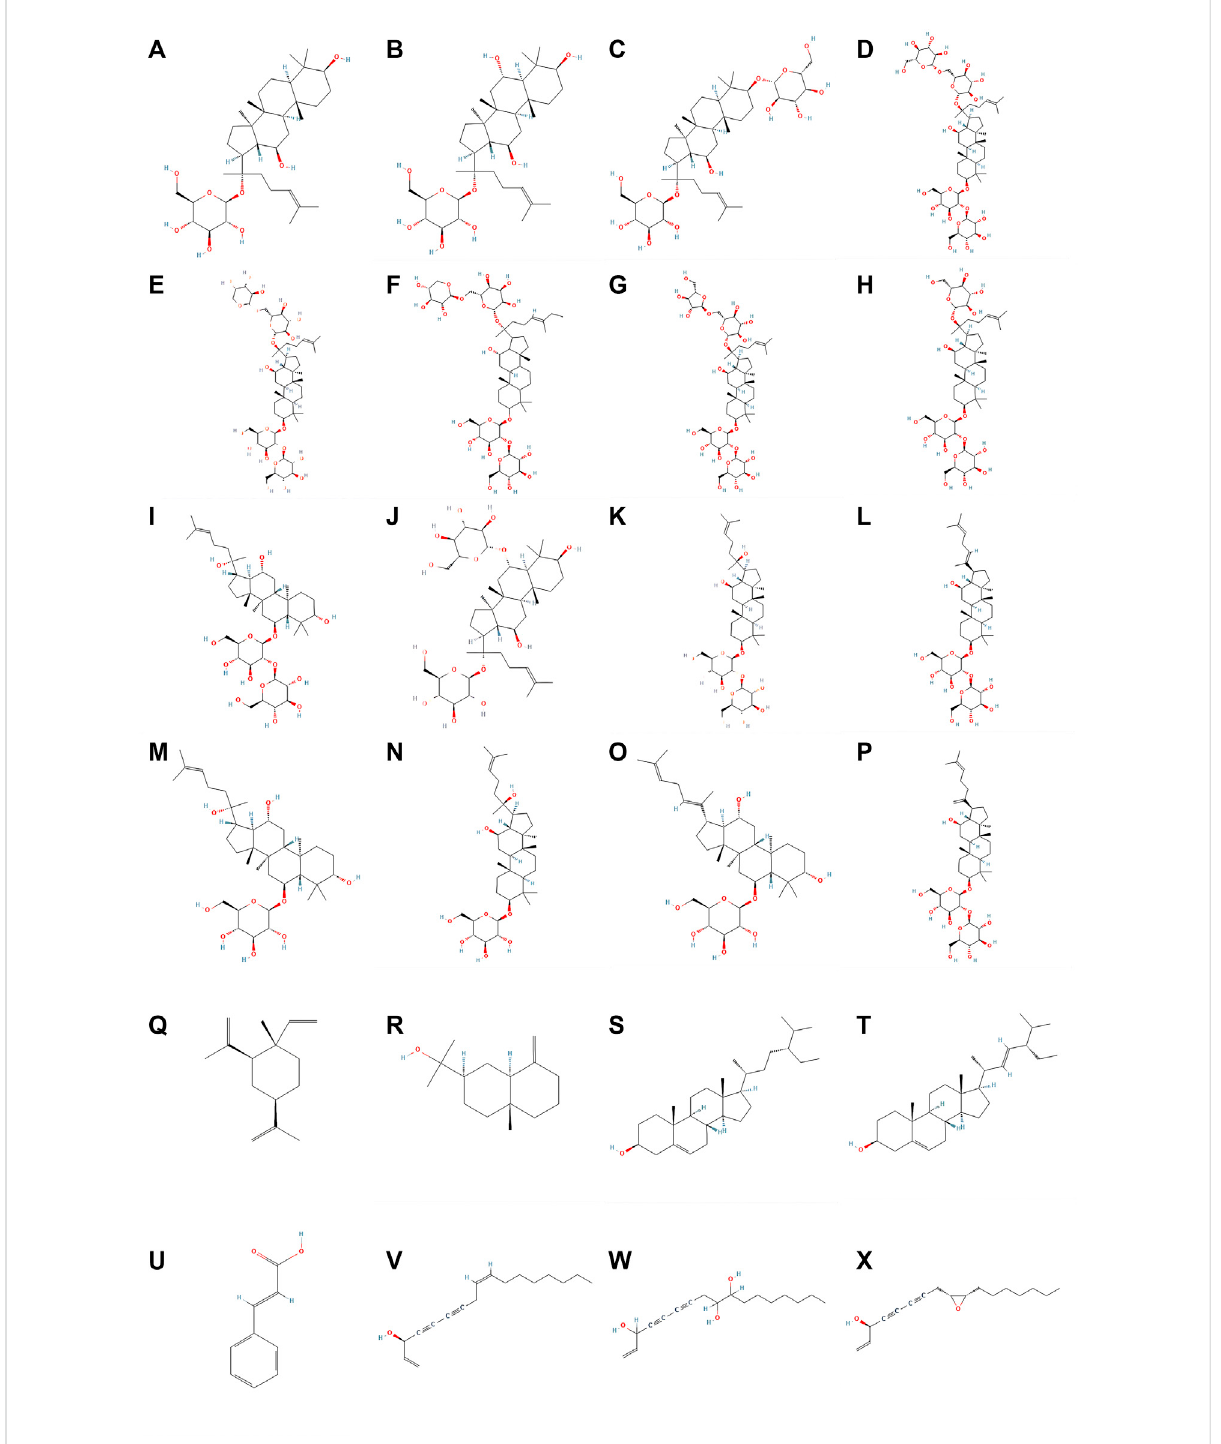
FIGURE 1 Molecular structureal formula of the main active ingredients of ginseng. (A) Ginsenosides-C-K (B) Ginsenosides-F1 (C) Ginsenosides-F2 (D) Ginsenosides-Rb1 (E) Ginsenosides-Rb2 (F) Ginsenosides-Rb3 (G) Ginsenosides-Rc (H) Ginsenosides-Rd (I) Ginsenosides-Rf (J) Ginsenosides-Rg1 (K) Ginsenosides-Rg3 (L) Ginsenosides-Rg5 (M) Ginsenosides-Rh1 (N) Ginsenosides-Rh2 (O) Ginsenosides-Rh4 (P) Ginsenosides-Rk1 (Q) beta- Elemene (R) beta-Eudesmol (S) beta-Sitosterol (T) Stigmasterol (U) Cinnamic_acid (V) Panaxynol (W) Panaxytriol (X) Panaxydol (Image